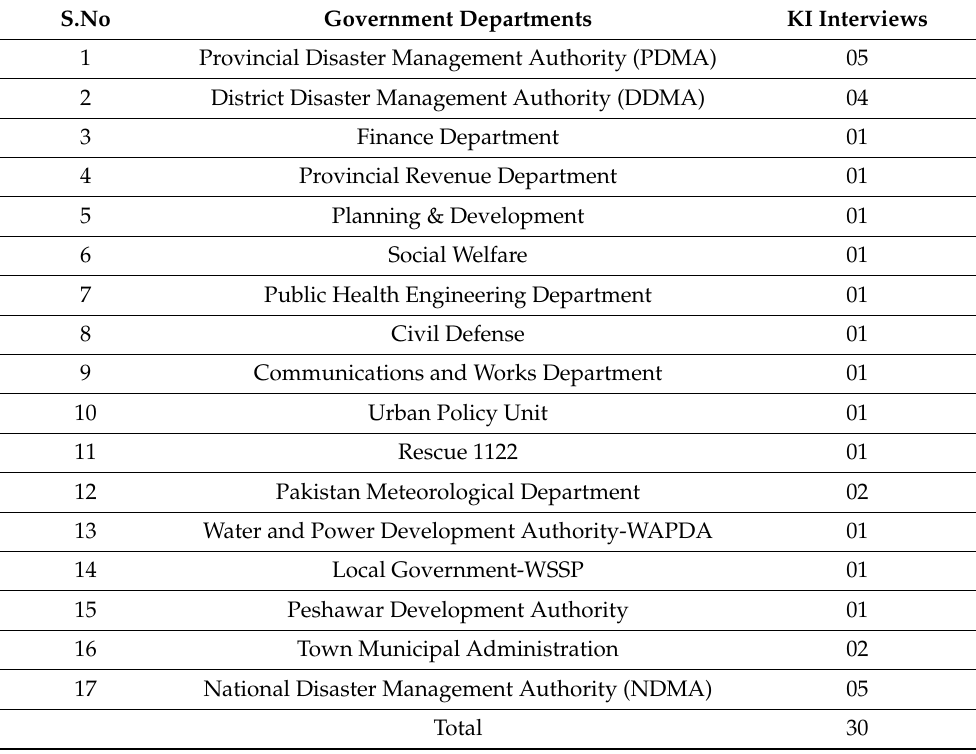
Table 1. Local institutions consulted during the study.